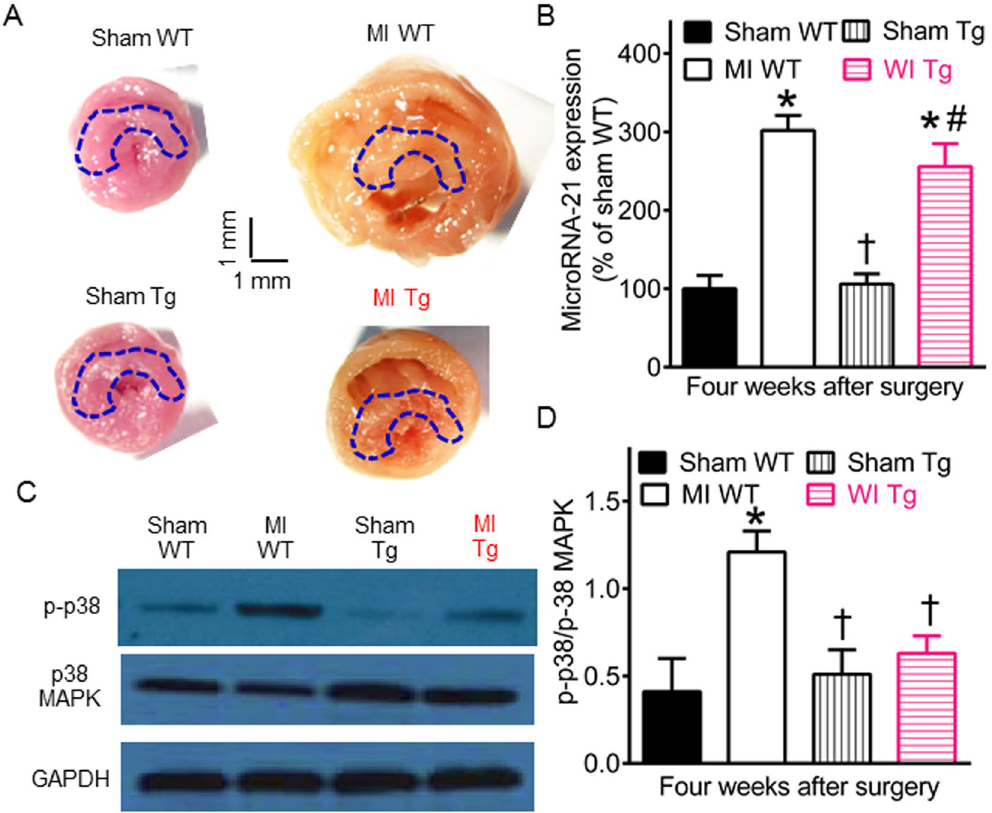
Figure 4. Effects of GTP cyclohydrolase 1 (GCH1) overexpression on microRNA-21 and p38 mitogen-activated protein kinase (MAPK) after myocardial infarction (MI). ( A ) Representative transverse sections of fresh mouse hearts showing the positon of tissue sampling for measurements of microRNA-21 and p38 MAPK 4 weeks after (MI) or sham surgery. The drawing areas indicate the position of tissue sampling, and the scales indicate 1 mm. ( B ) The expression of microRNA-21 mRNA; ( C ) representative Western blot bands showing the expression of phosphorylated p38 (p-p38) MAPK, total p38 MAPK, and GAPDH; ( D ) The ratio of phosphorylated p38 (p- p38) MAPK/p38 MAPK. * P < 0.05 versus sham WT groups; † P < 0.05 versus MI WT groups; # P < 0.05 versus sham Tg groups (n = 8–10